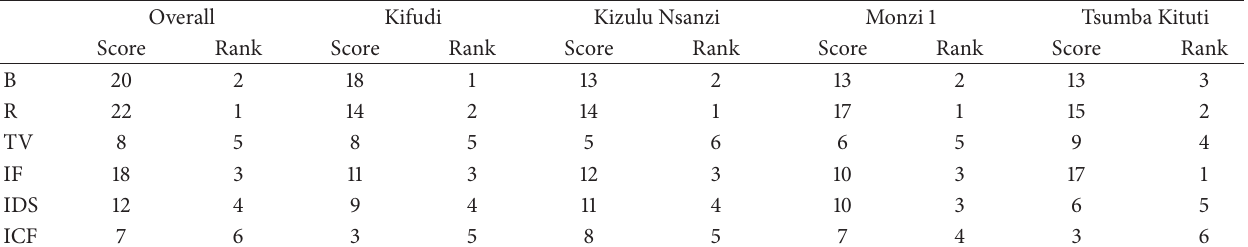
Table 4: Scoring and ranking of the alternative activities proposed to the villages studied.